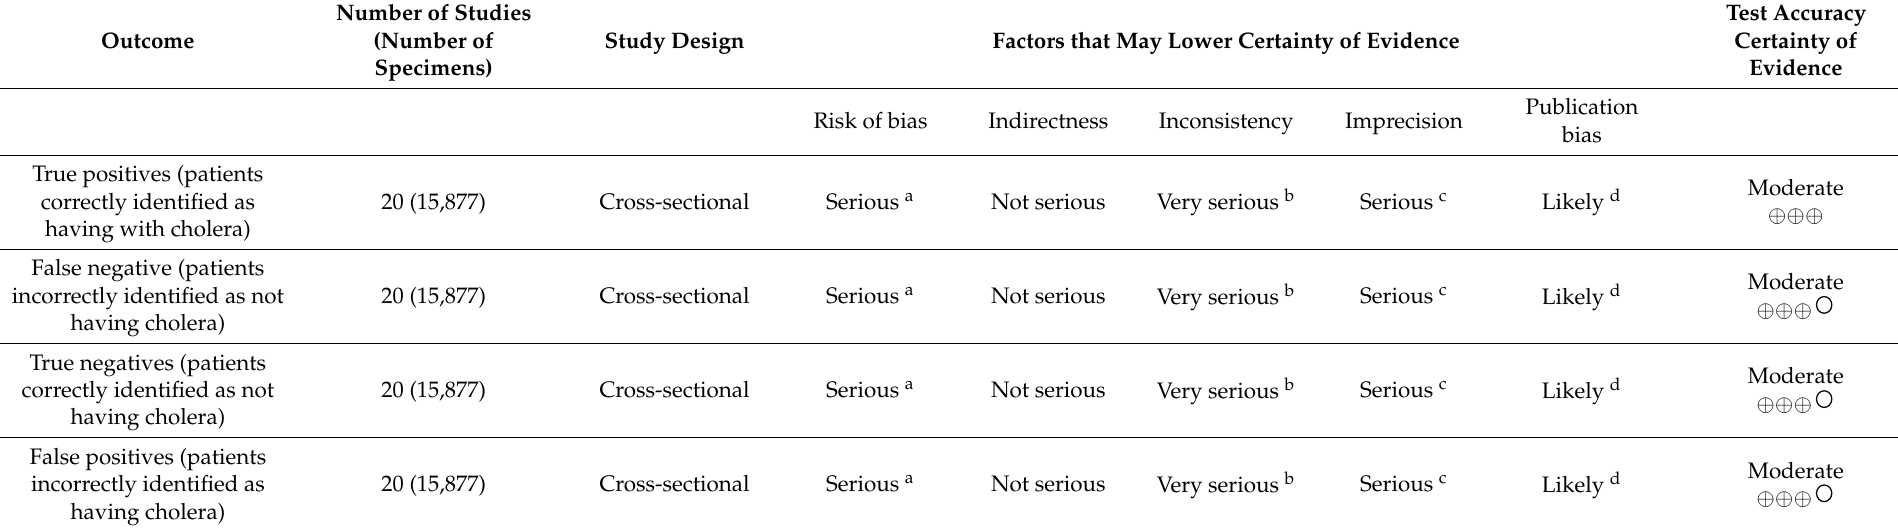
Table 3. GRADE certainty of evidence for cholera RDTs: should current cholera RDTs be used in patients suspected of cholera for surveillance or earlier outbreak detection?